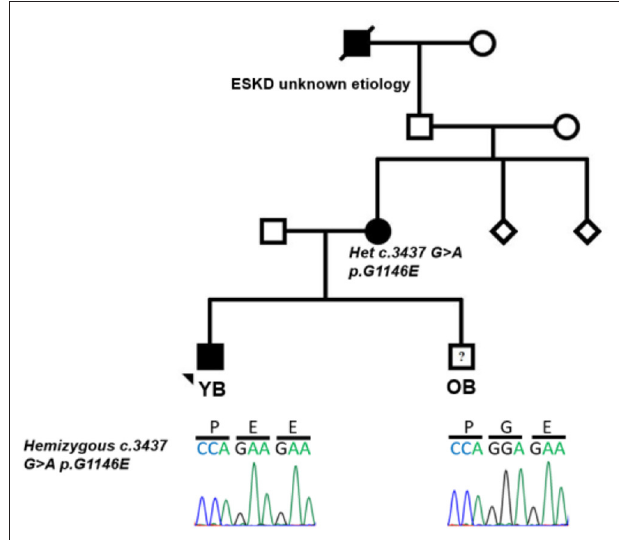
FIGURE 1 | Pedigree of family with aggregation of different glomerular diseases showing segregation of c.3437 G > A p.G1146E in COL4A5. Filled circle and square represent affected individuals; unfilled circle, square, and diamond represent unaffected individuals.